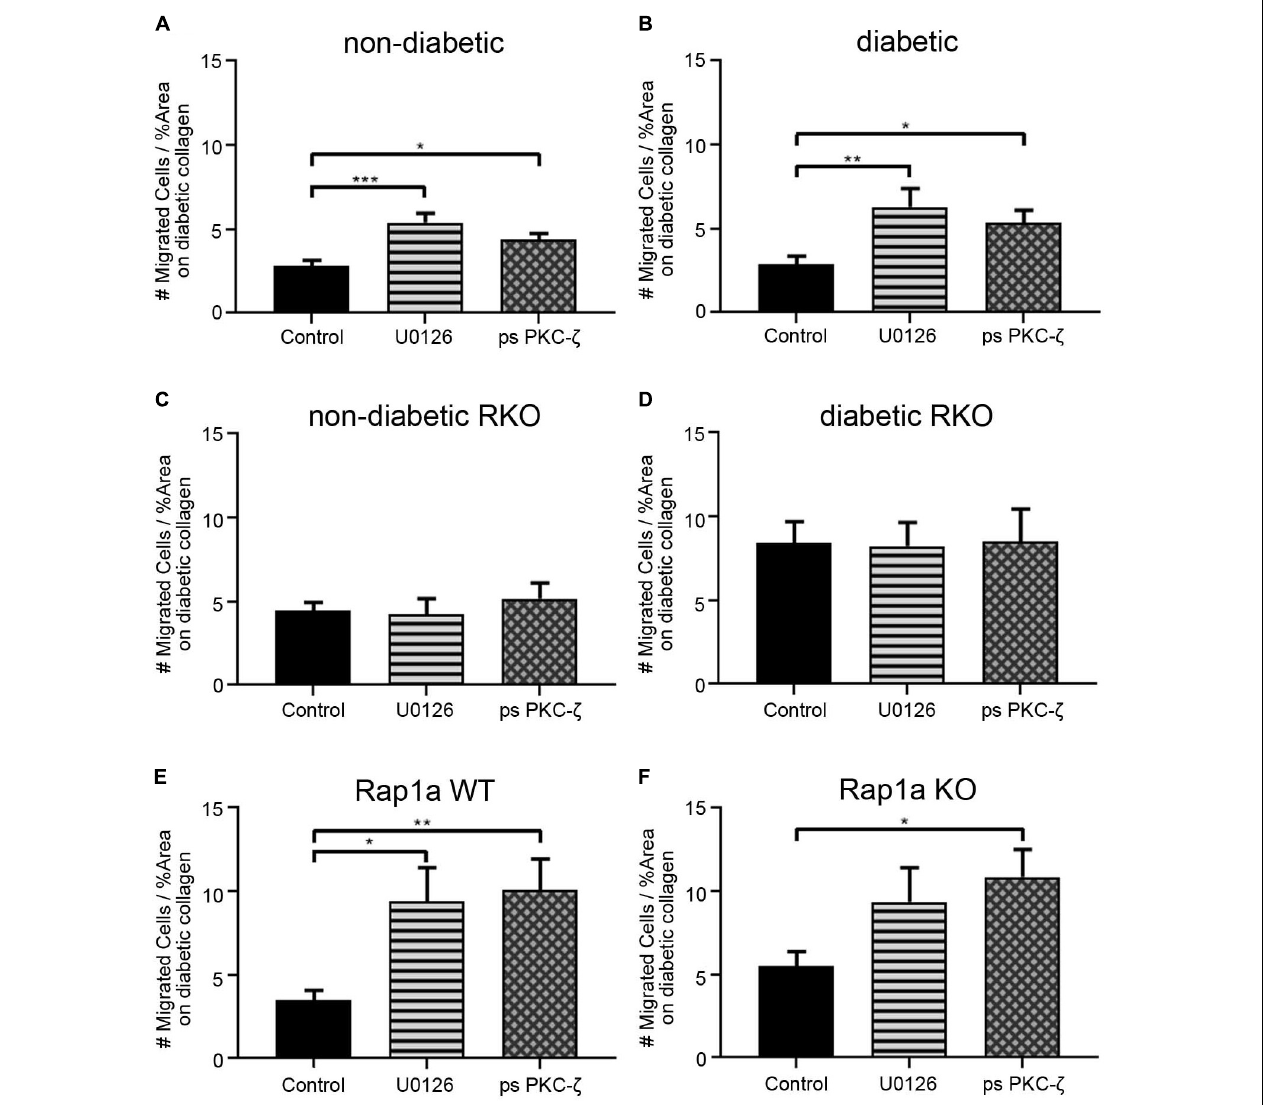
FIGURE 5 | Cardiac fibroblasts display increased migration with decreased RAGE signaling on diabetic collagen. (A) Non-diabetic, (B) diabetic, (C) non-diabetic RKO, (D) diabetic RKO, (E) Rap1a WT, and (F) Rap1a KO cardiac fibroblasts plated on diabetic collagen were treated with U0126 (ERK inhibitor; 5 µ M) and